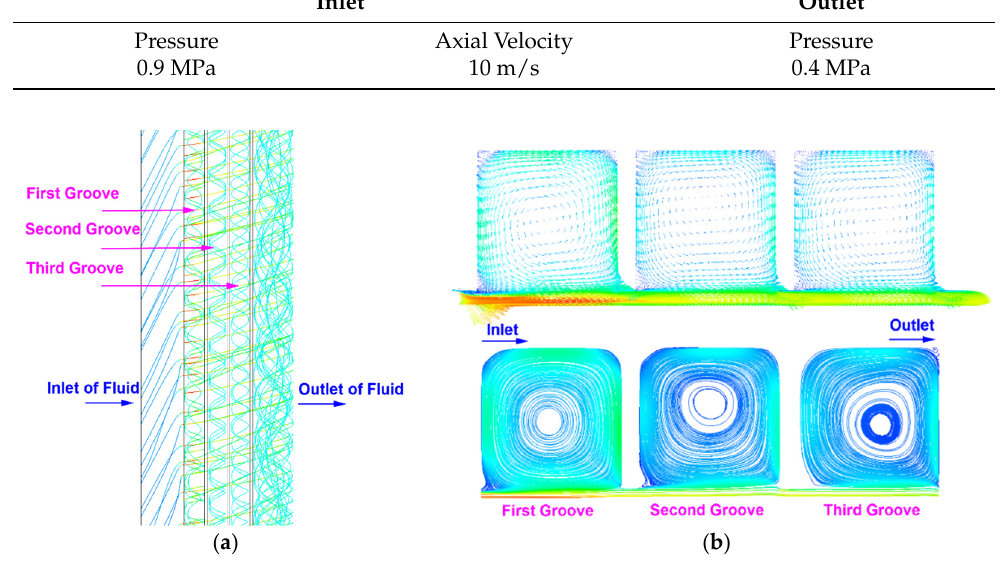
Figure 3. ( a ) 3D streamline diagram; ( b ) Vector diagram and streamline diagram of fluid field.